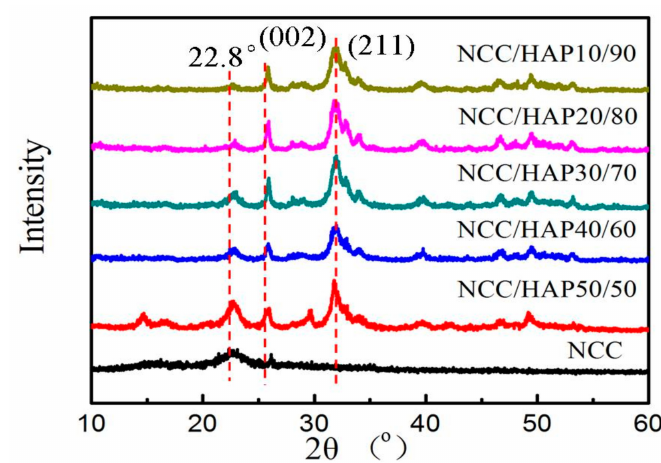
Figure 4. X-ray diffraction (XRD) of NCC, NCC / HAP50 / 50, NCC / HAP40 / 60, NCC / HAP30 / 70, NCC / HAP20 / 80 and NCC / HAP10 / 90.